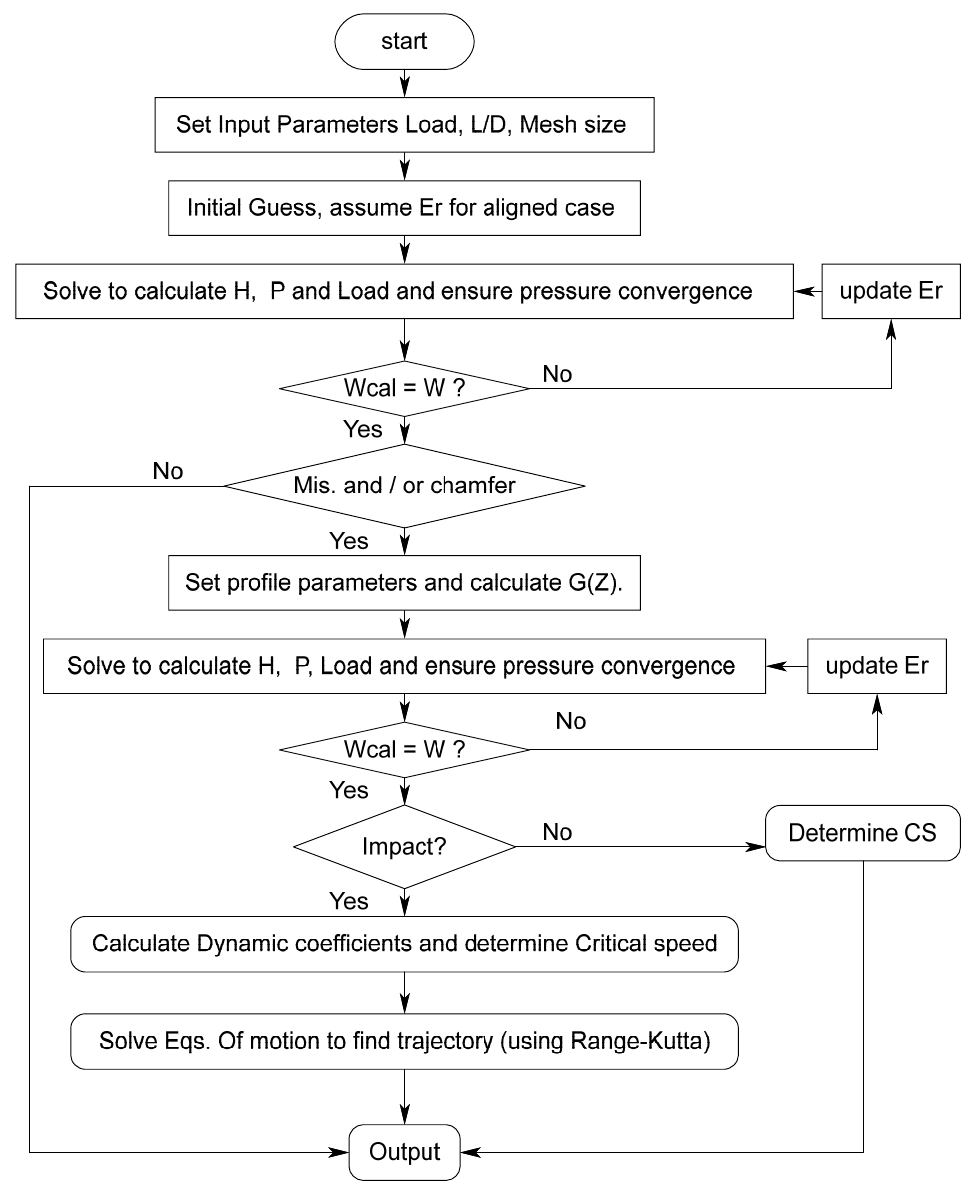
Figure 4. Flowchart of the solution steps.